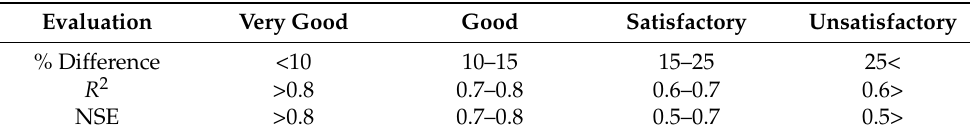
Table 2. Evaluation criteria for flow simulation result of the HSPF model